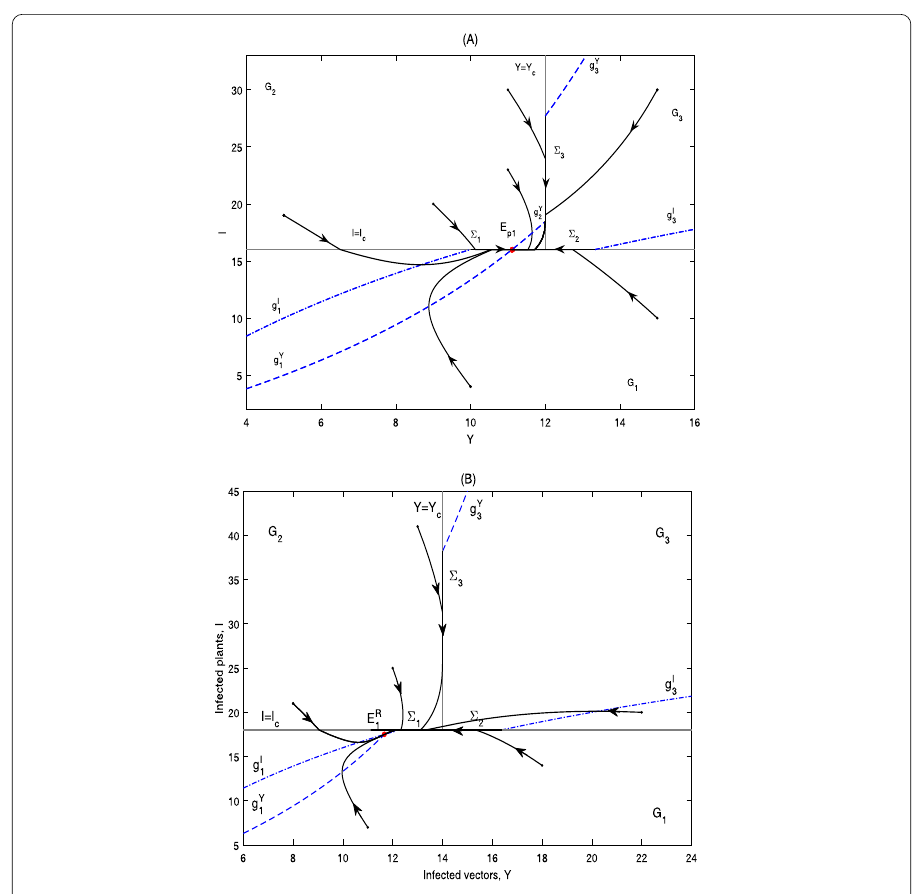
Figure 14 Global dynamics in Case D.12. ( A ) E p 1 is globally asymptotically stable. Y c = 12, I c = 16. ( B ) E R 1 is globally asymptotically stable. Y c = 14, I c =